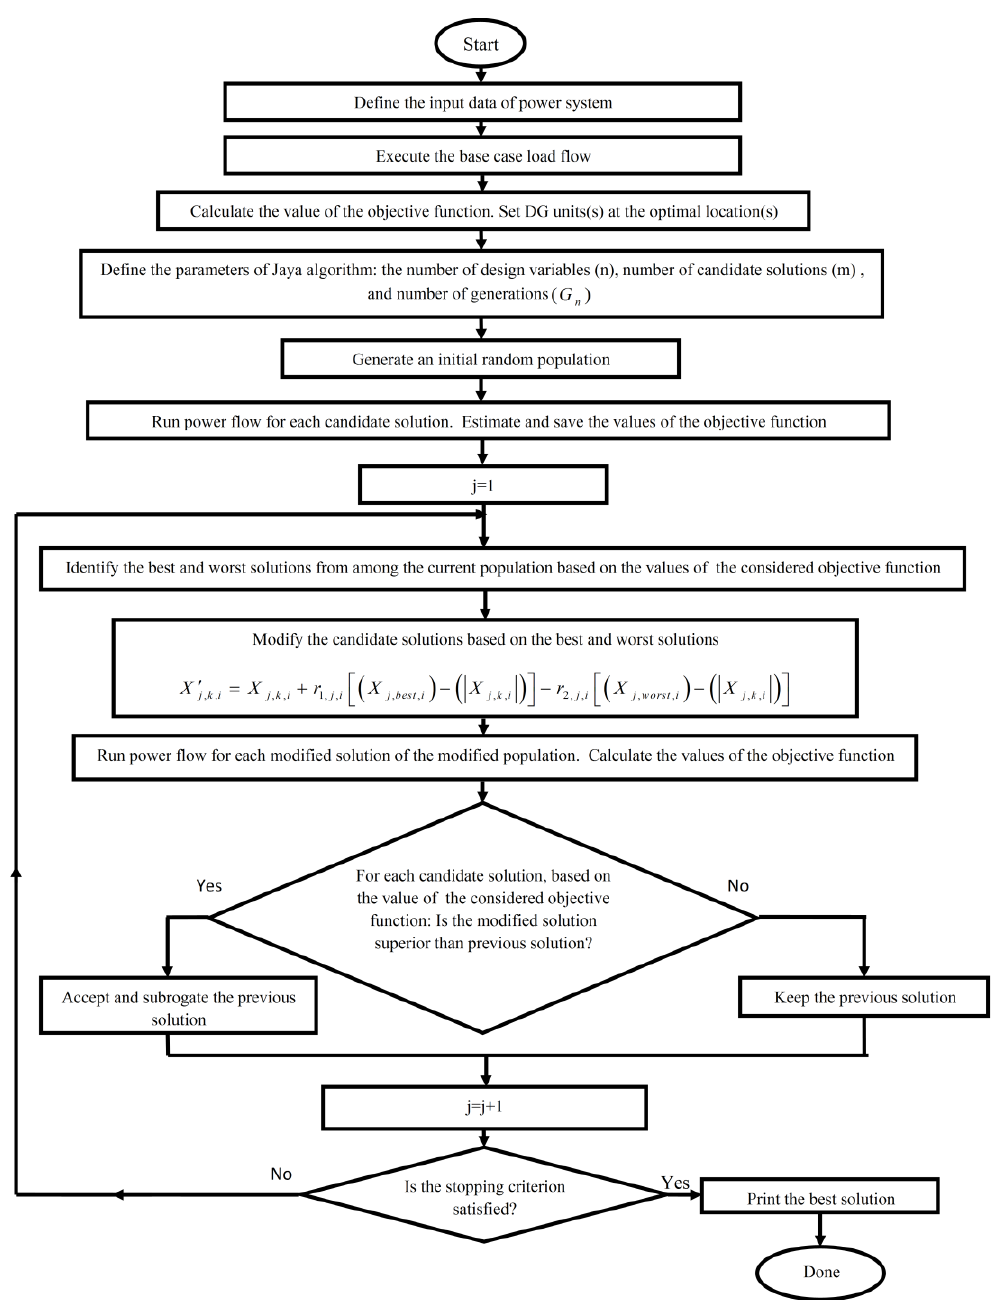
Figure 2. Flowchart of the application of Jaya algorithm for the OPF problem.